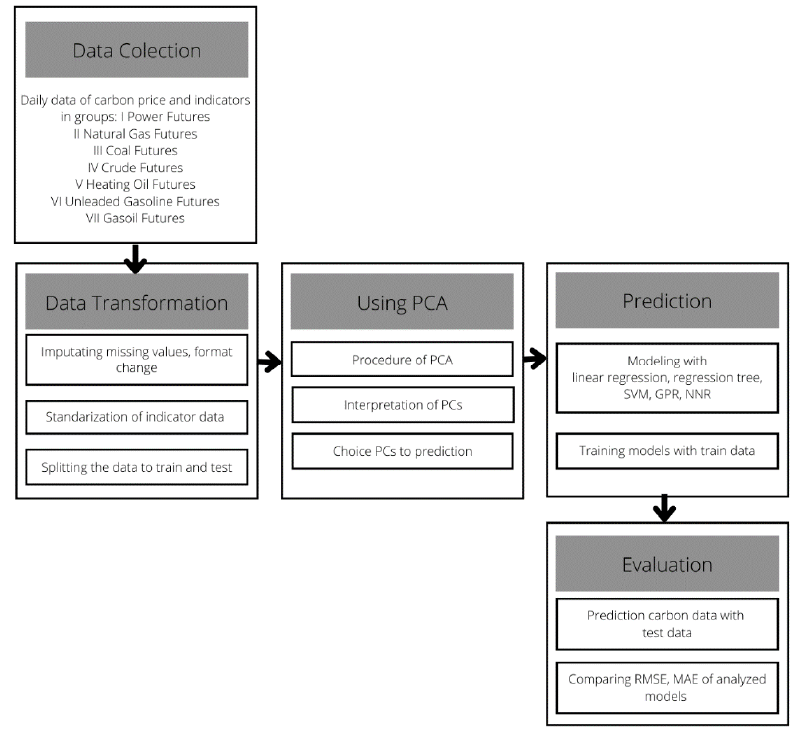
Figure 1. Block diagram for the methodology used.